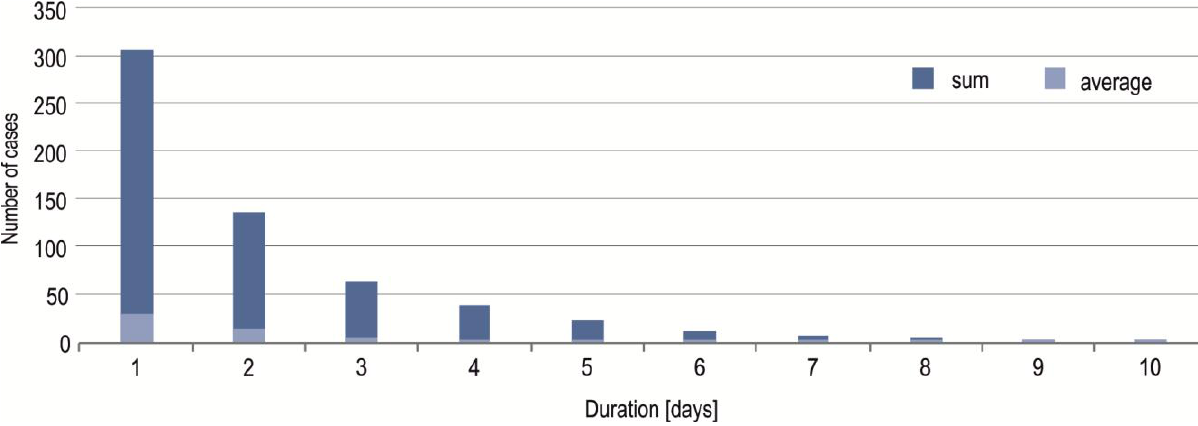
Fig. 6. Number of sequences of days without atmospheric fronts in Poland in the period